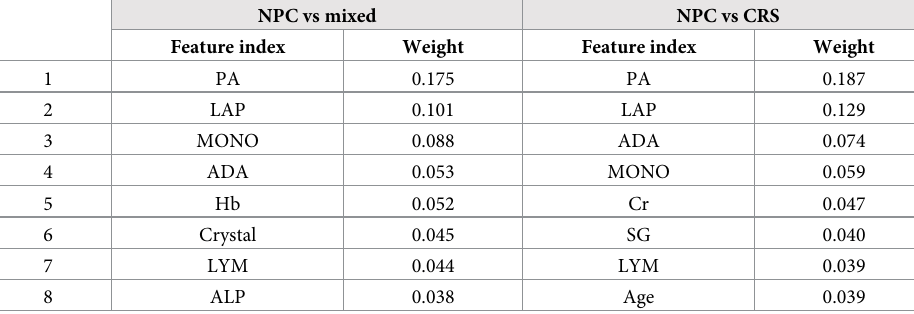
Table 6. Top importance rankings given by